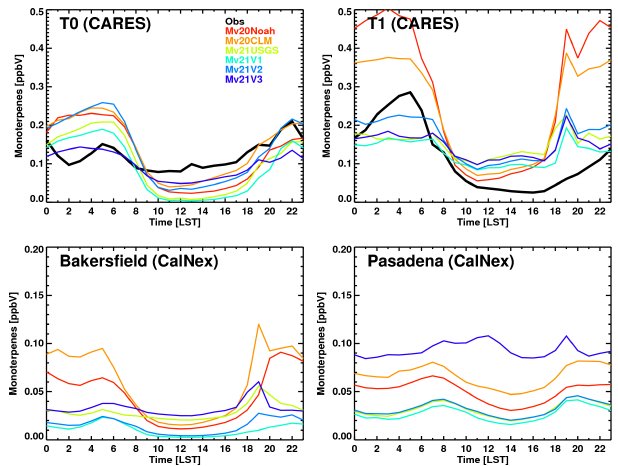
Figure 15. Monthly averaged diurnal variation of surface monoter- pene mixing ratios at the four observation sites from the observa- tions and six simulations as listed in Table 2. There are no observa- tions for the Bakersfield and Pasadena sites in June.